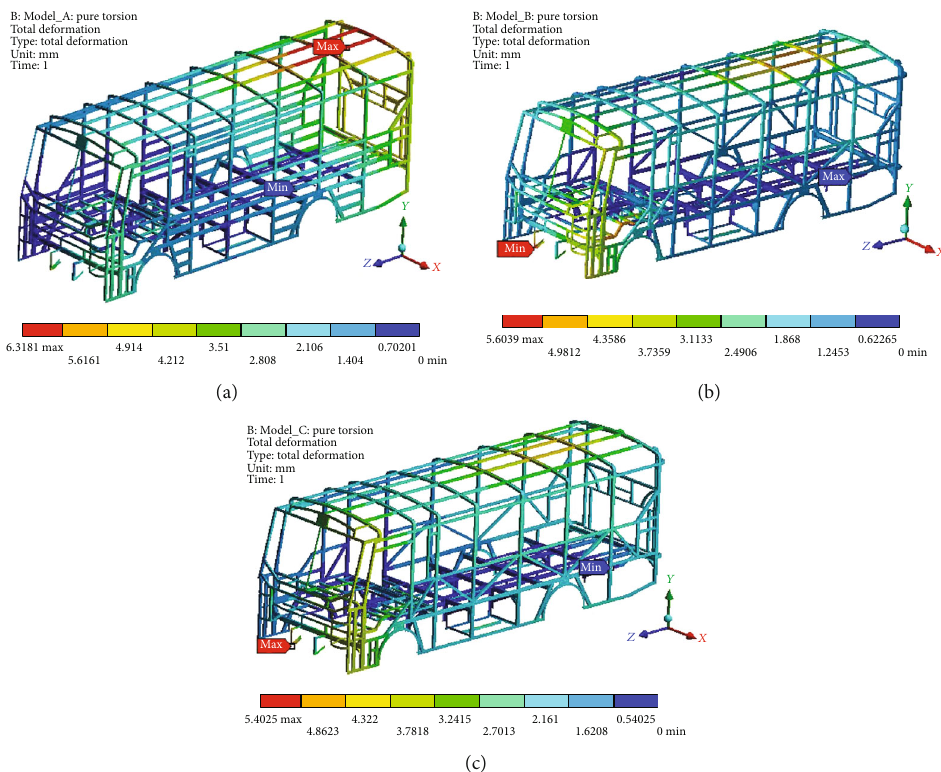
Figure 18: Total deformation in pure torsion: (a) baseline model; (b) model I (RD); (c) model II (RSO).